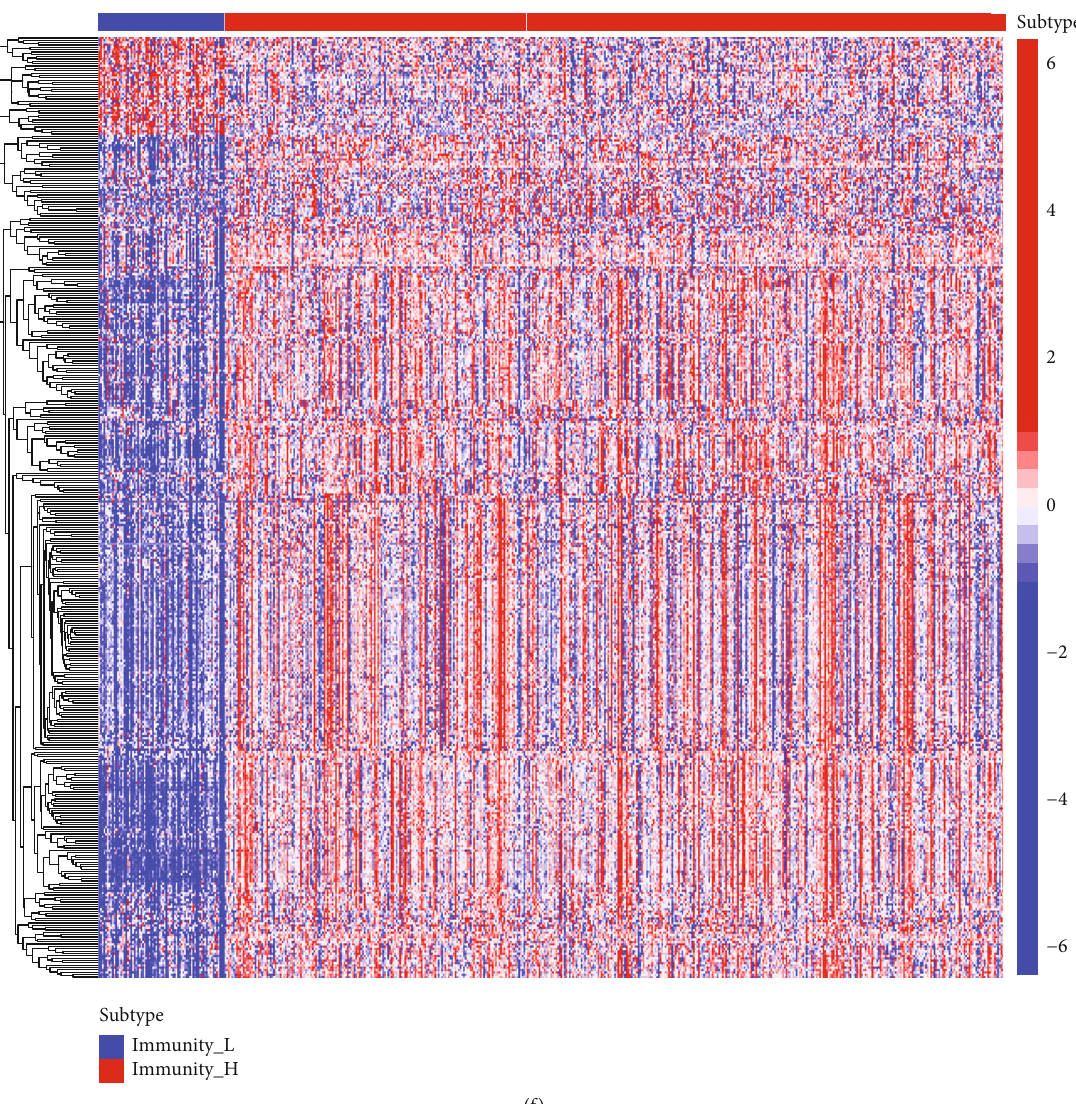
Figure 2: The levels of immune cells in fi ltration, HLA genes expression, DEGs, and DEIGs analyses in Immunity_H and Immunity_L. (a) Comparison of the levels of immune cells in fi ltration between Immunity_H and Immunity_L. (b) Comparison of HLA genes expression levels between Immunity_H and Immunity_L. (c) Volcano plot of all DEGs, Immunity_H vs. Immunity_L, |LogFC| > 0.585, and FDR < 0.05. (d) Venn diagram of DEGs and immune genes. (e) Landscape of DEGs between Immunity_H vs. Immunity_L. (f) Landscape of DEIGs between Immunity_H and Immunity_L. ∗ p < 0 : 05 , ∗∗ p < 0 : 01 , and ∗∗∗ p < 0 : 001